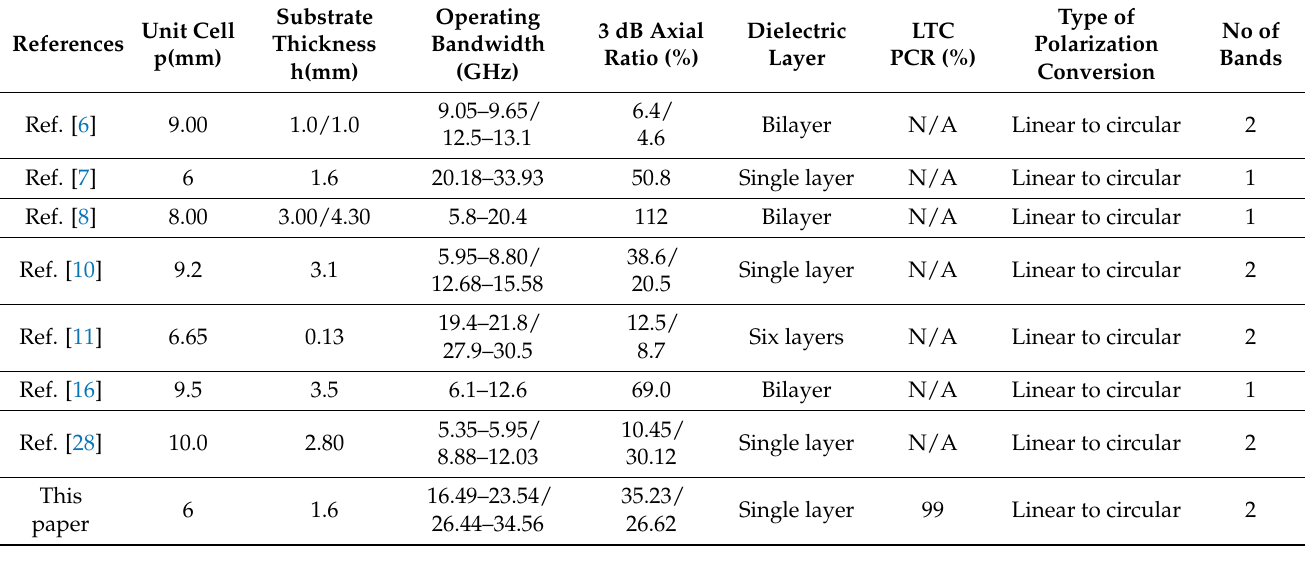
Table 2. Comparative study of LTC polarization conversion of the proposed metasurface with the previously published works.